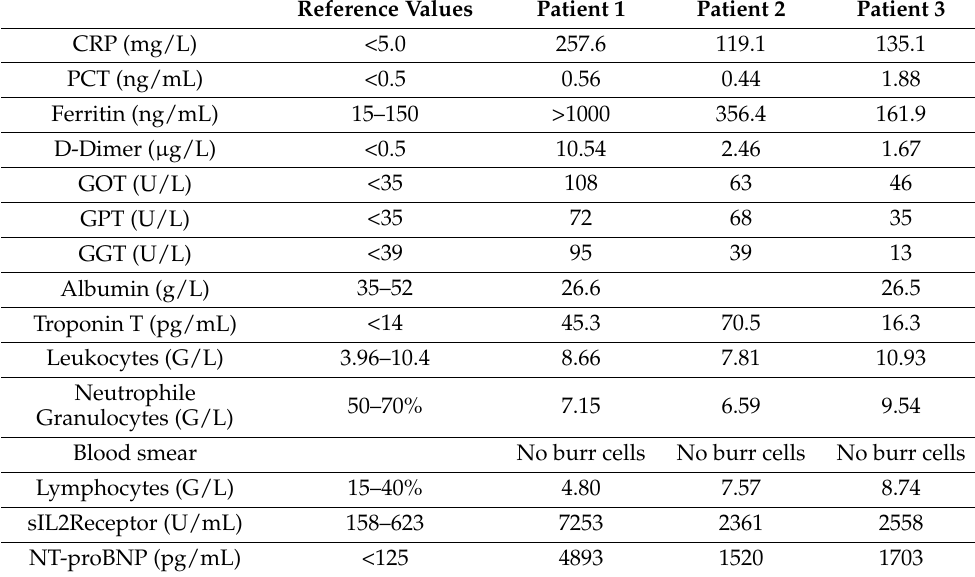
Abbreviations: CRP: C-reactive protein, PCT: Procalcitonin, GOT: Glutamate-oxalacetate transaminase, GPT: Glutamate-pyruvate transaminase, GGT: Gamma glutamyl transferase, sIL2 Receptor: Soluble IL2 receptor, NT-proBNP: N terminal pro brain natriuretic